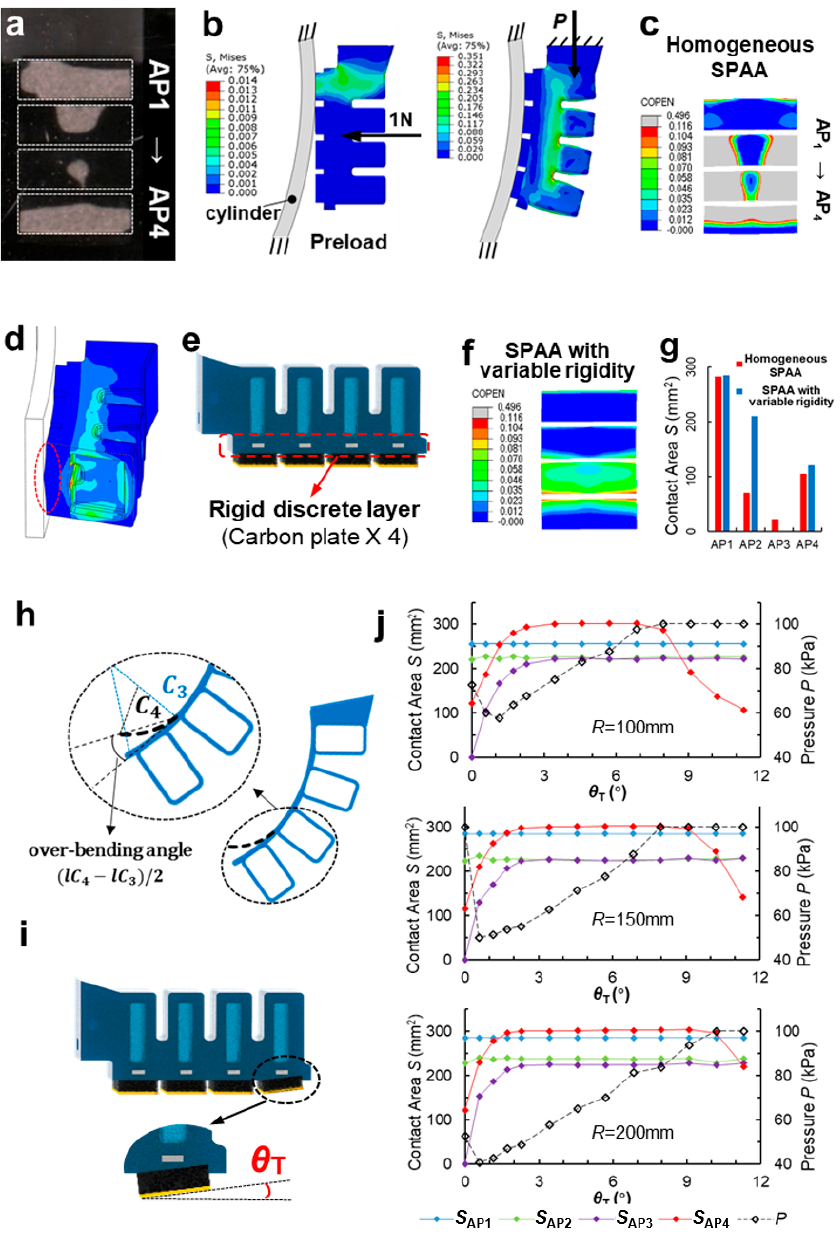
Figure 8. ( a ) The contact state of the SPAA during adhesion. ( b ) The finite element model describing the contact of the SPAA. ( c ) The simulation results of the contact areas of four Aps of the original SPAA with homogeneous structure. ( d ) The simulated cross-section of the SPAA in contact with the cylinder. ( e ) The optimized SPAA with a rigid–flexible coupled hierarchical structure. ( f ) The simulation results of the contact areas of four APs of the optimized SPAA with variable rigidity. ( g ) The increase. ( h ) Illustration of the over-bending angle of PN4 with respect to PN3. ( i ) The optimized SPAA with a differentiated AP structure. ( j ) The contact area and air pressure of each AP versus θ T (0 ◦ ~12 ◦ ) when the SPAA with an 8 mm rib height reaches the steady